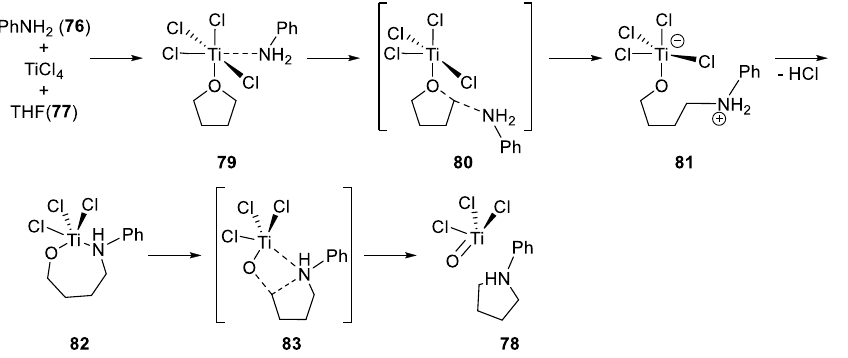
Scheme 17. TiCl 4 - mediated synthesis of azacycles from anilines and cyclic ethers.